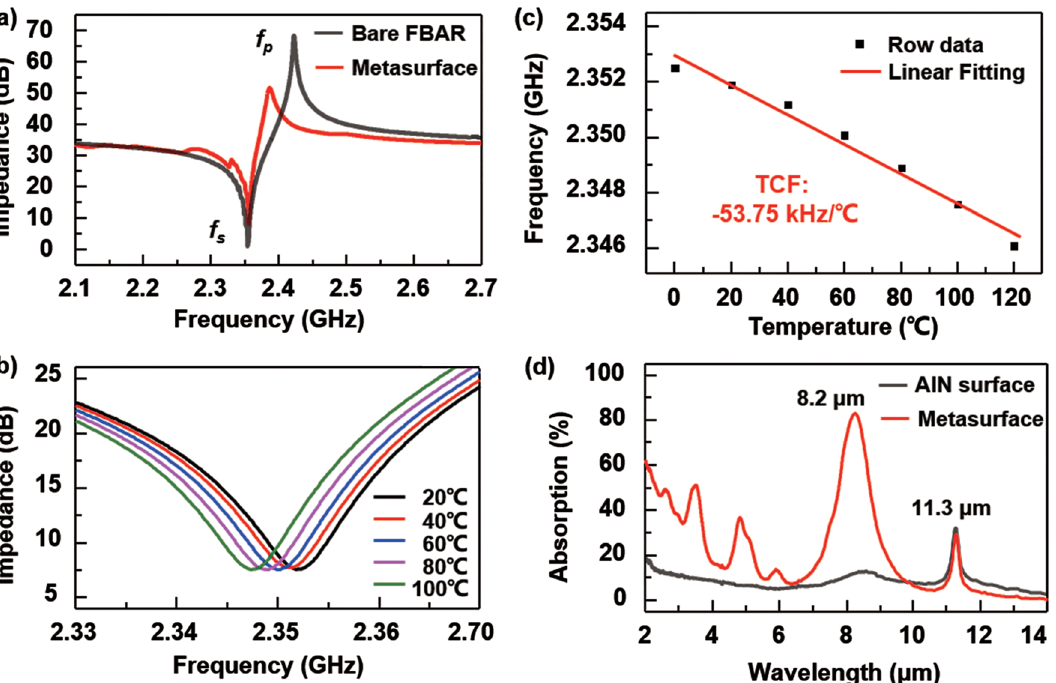
Figure 2: (a) Frequency response of the film bulk acoustic wave resonator (FBAR) with perfect metamaterial absorber (PMA) (red line) and without PMA (black line). (b) Frequency responses of the proposed sensor recorded at temperatures from 20 to 100 ° C. (c) Temperature coef fi cient of frequency (TCF) also referred to as temperature responsivity ( R ts ) of the proposed sensor was evaluated from measurements as − 53.75kHz/ ° C( − 23ppm/K).(d)Infrared(IR)absorptionofperfectmetamaterialabsorber(redline)andAlNsurface(blackline)measuredby Fourier transform infrared (FTIR)